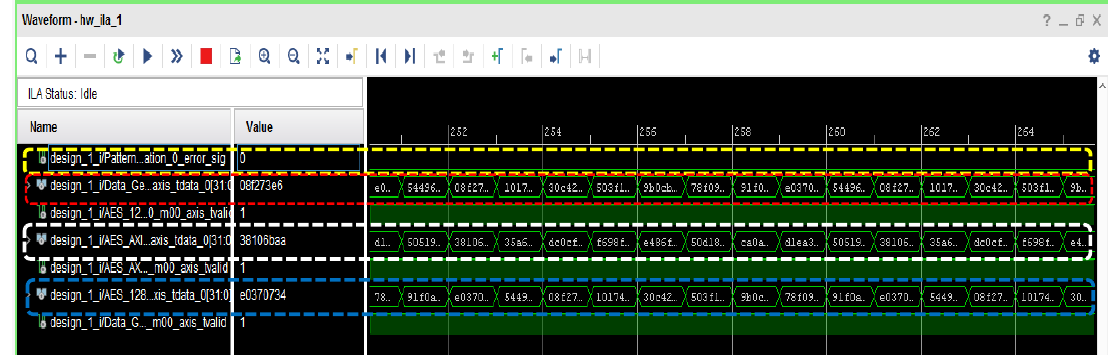
Figure 25. Temporal trends with shown the plaintext data packets provided to the system on each rising edge of the clock; the packets are obtained from the decryption block after 20 clock periods, 10 of which needed for encryption operation and the remaining 10 for the decryption one. The error_sig signal, highlighted in yellow, is low along the whole observation interval, as expected. The packets leaving the decryption block (blue-dashed box) are equal to those entering the encryption block (red-dashed box).